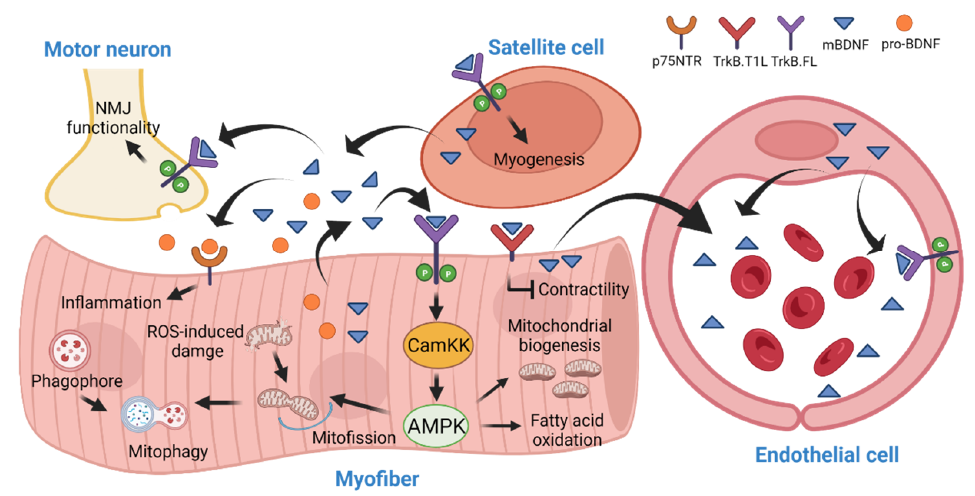
Figure 4. Functional activities of BDNF in skeletal muscle (Skm). In Skm, mBDNF is produced by the myofiber, satellite cells, and blood vessel endothelial cells. It acts in an autocrine and paracrine manner to modulate the mitochondrial dynamics and lipid metabolism in myofibers, control the myogenesis, and maintain the functions of the neuromuscular junction. The myofiber-generated BDNF is also secreted into circulation to regulate the functions of the pancreas.